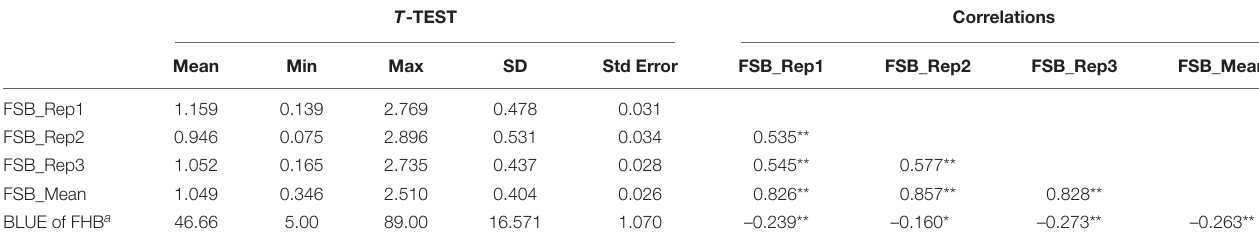
TABLE 1 | Descriptive statistics and correlation coefficients of Fusarium seeding blight and Fusarium head blight of 240 wheat cultivars (lines). T -TEST